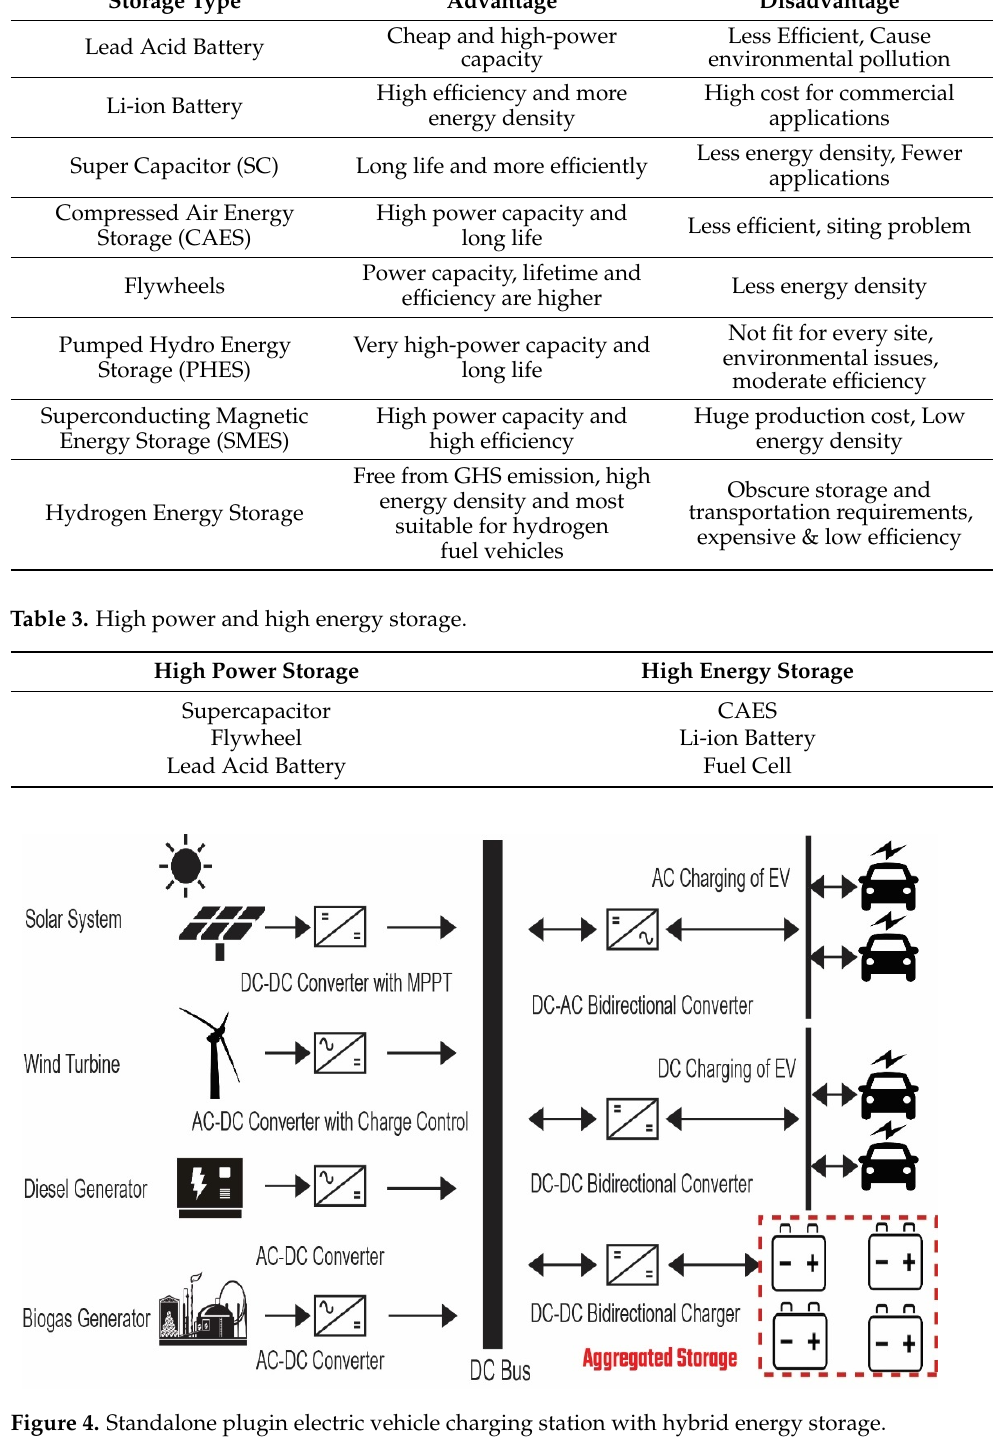
Table 2. Pros and cons of different storage systems.